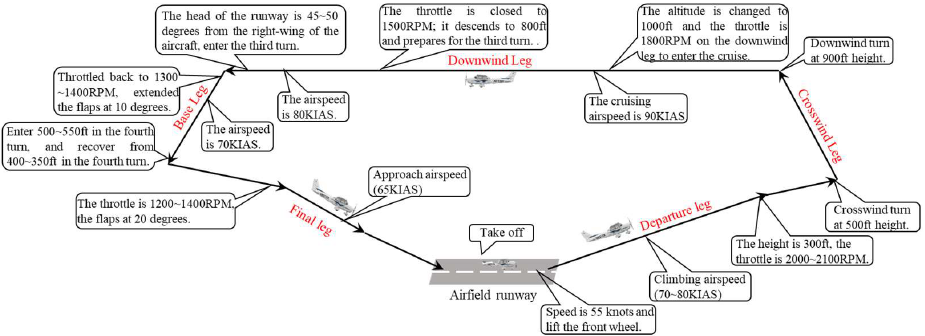
Figure 1. Flight diagram of the airfield traffic pattern.